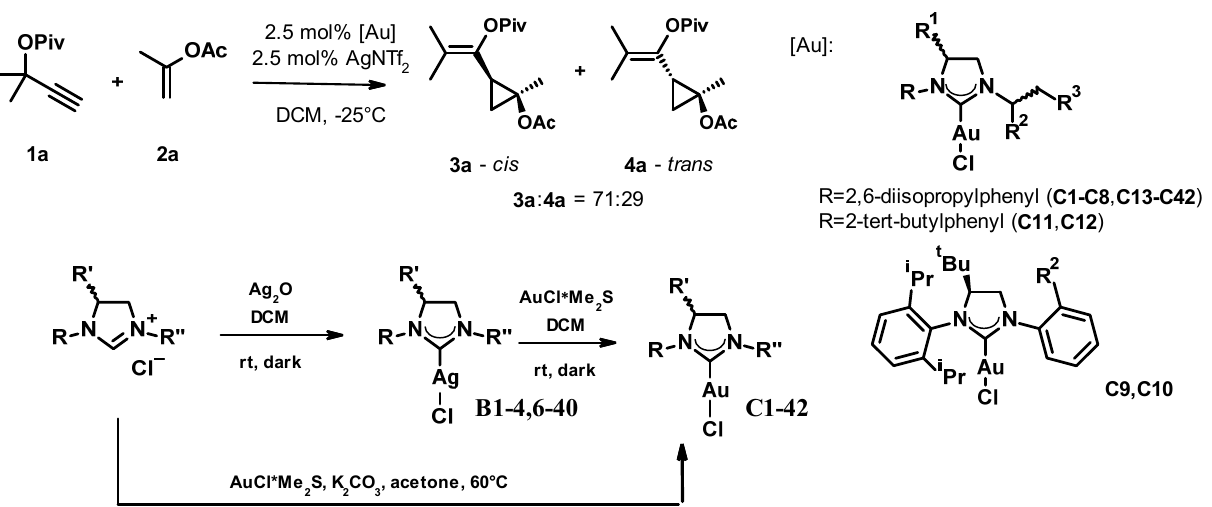
Figure 2. The optimization of the asymmetric cyclopropanation reaction and the general synthesis scheme of the used catalysts. Table 1. Catalyst screening ( C1–42 ) in the asymmetric cyclopropanation.